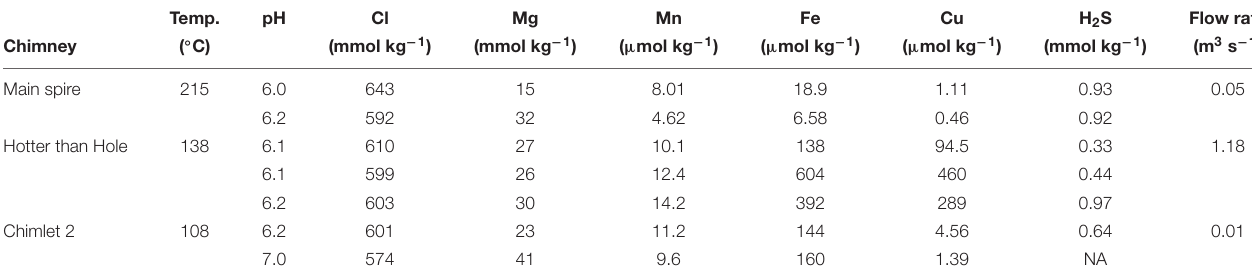
TABLE 1 | Hydrothermal vent fluid composition at the Von Damm vent field. Temp. pH Cl Mg Mn Fe Cu H 2